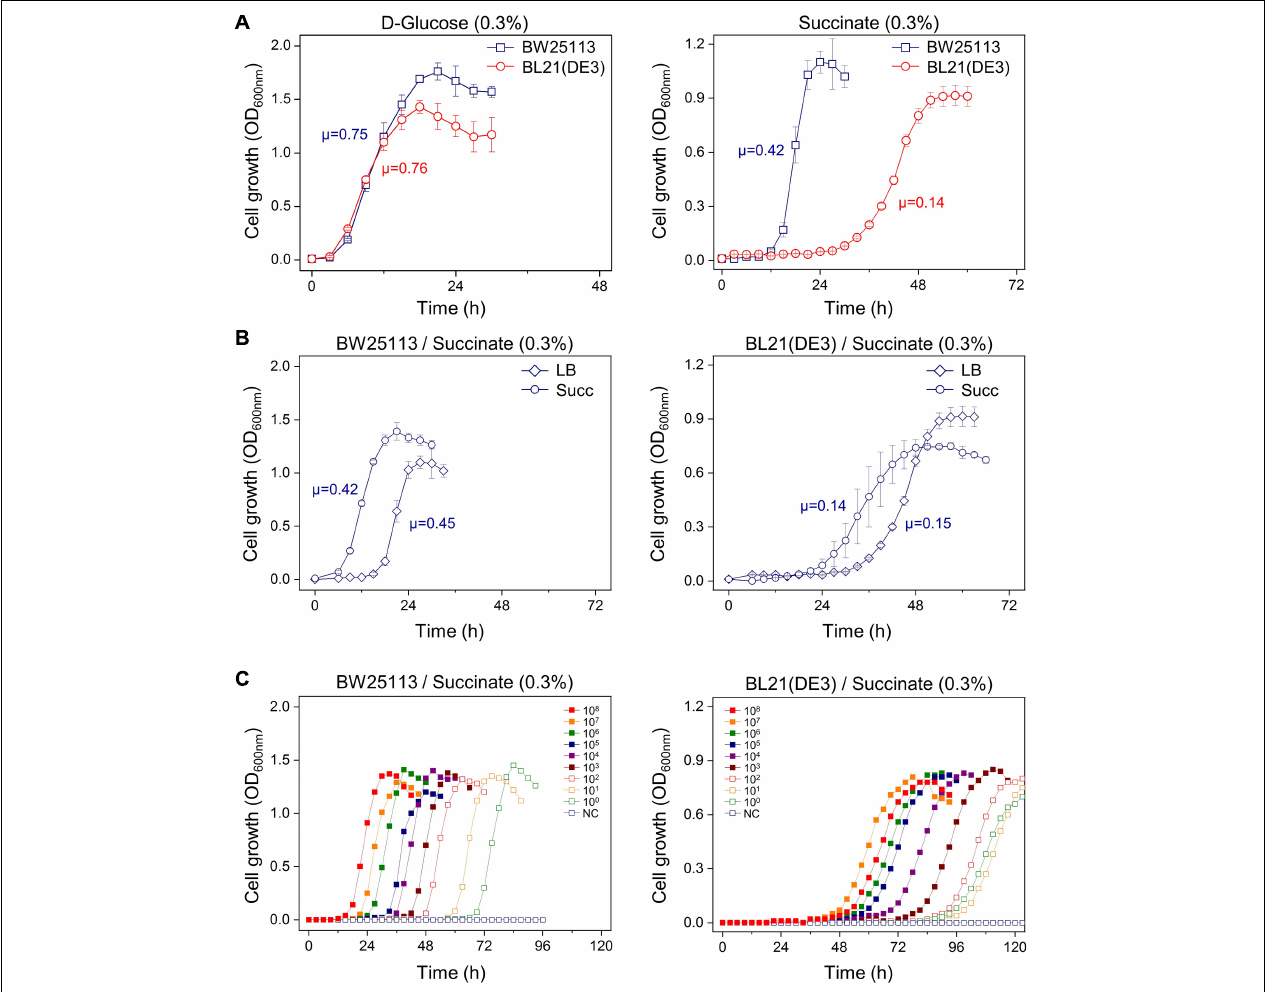
FIGURE 1 | Factors affecting the length of the lag phase of E. coli BW25113 and BL21(DE3). (A) Different carbon sources; cells grown in LB broth were washed and transferred to M9 minimal medium containing D -glucose or succinate. (B) Different preculture medium; cells grown in LB and M9 succinate medium were washed and transferred to M9 succinate medium. (C) Different inoculum size; cells grown in LB broth were washed and transferred to M9 succinate medium. NC, no cells were inoculated. The unit of specific growth rate ( µ ) is h − 1